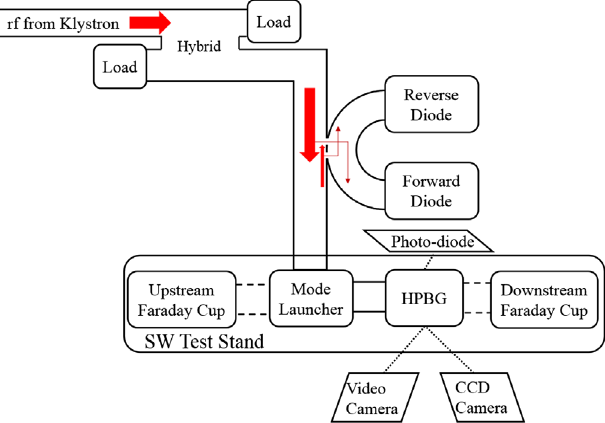
FIG. 20. Diagnostics used for the high power testing of the HPBG